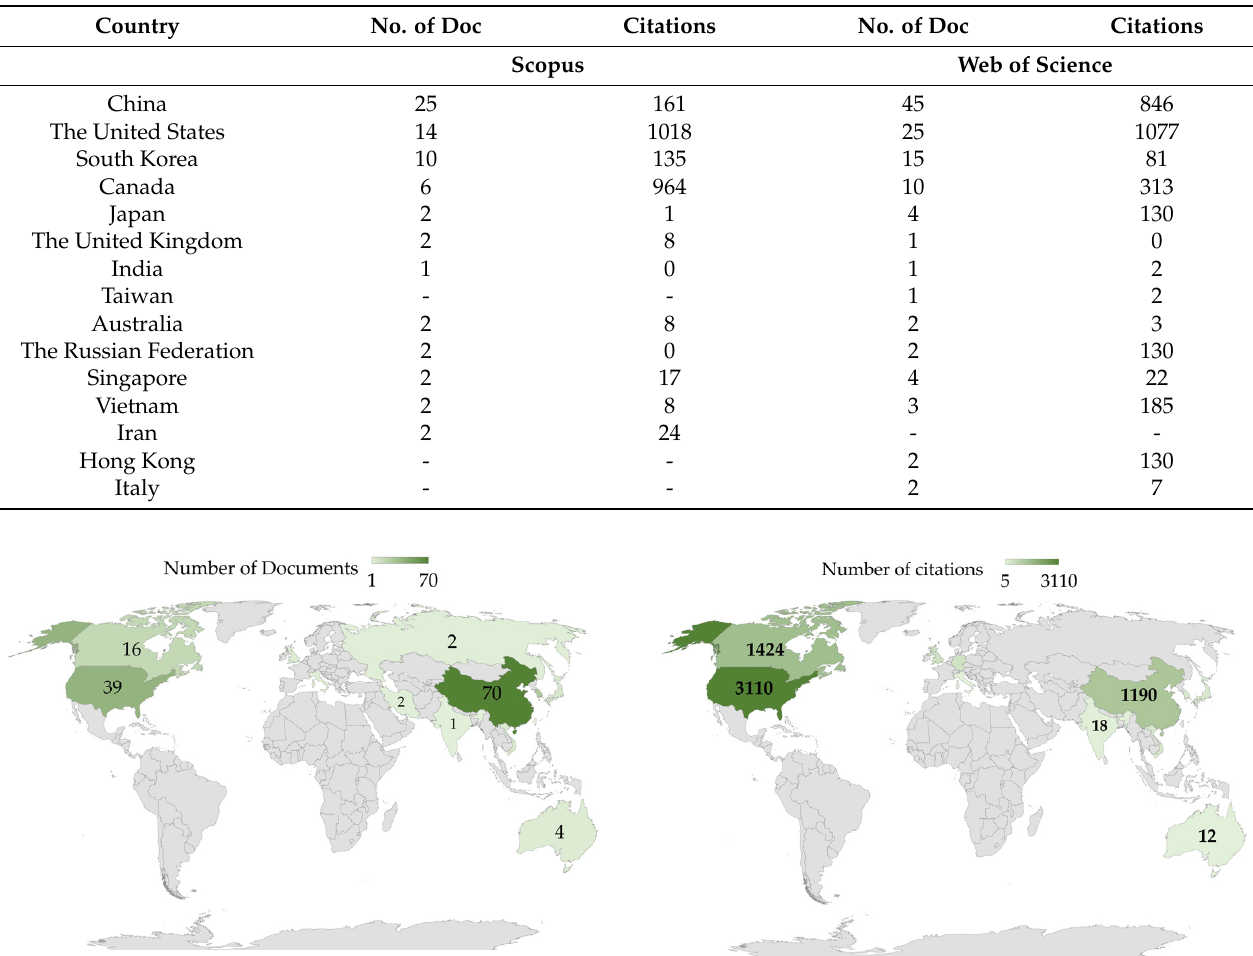
Figure 7. Country of origin (No. of documents and citations) analysis.